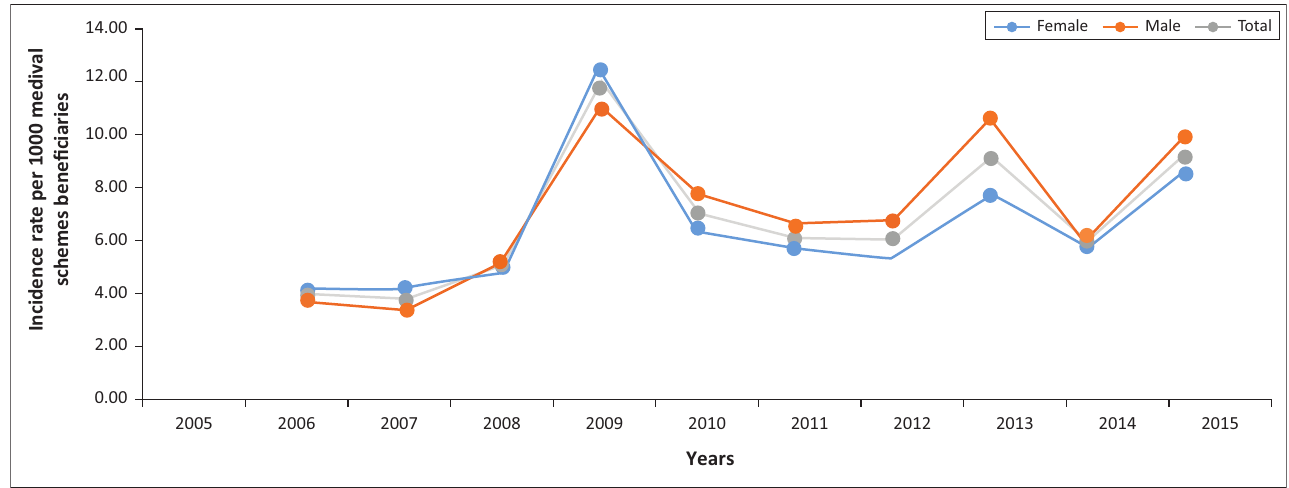
FIGURE 2: Human immunodeficiency virus or acquired immunodeficiency syndrome incidence rate per 1000 medical scheme beneficiaries per gender in the medical schemes environment of South Africa between 2005 and